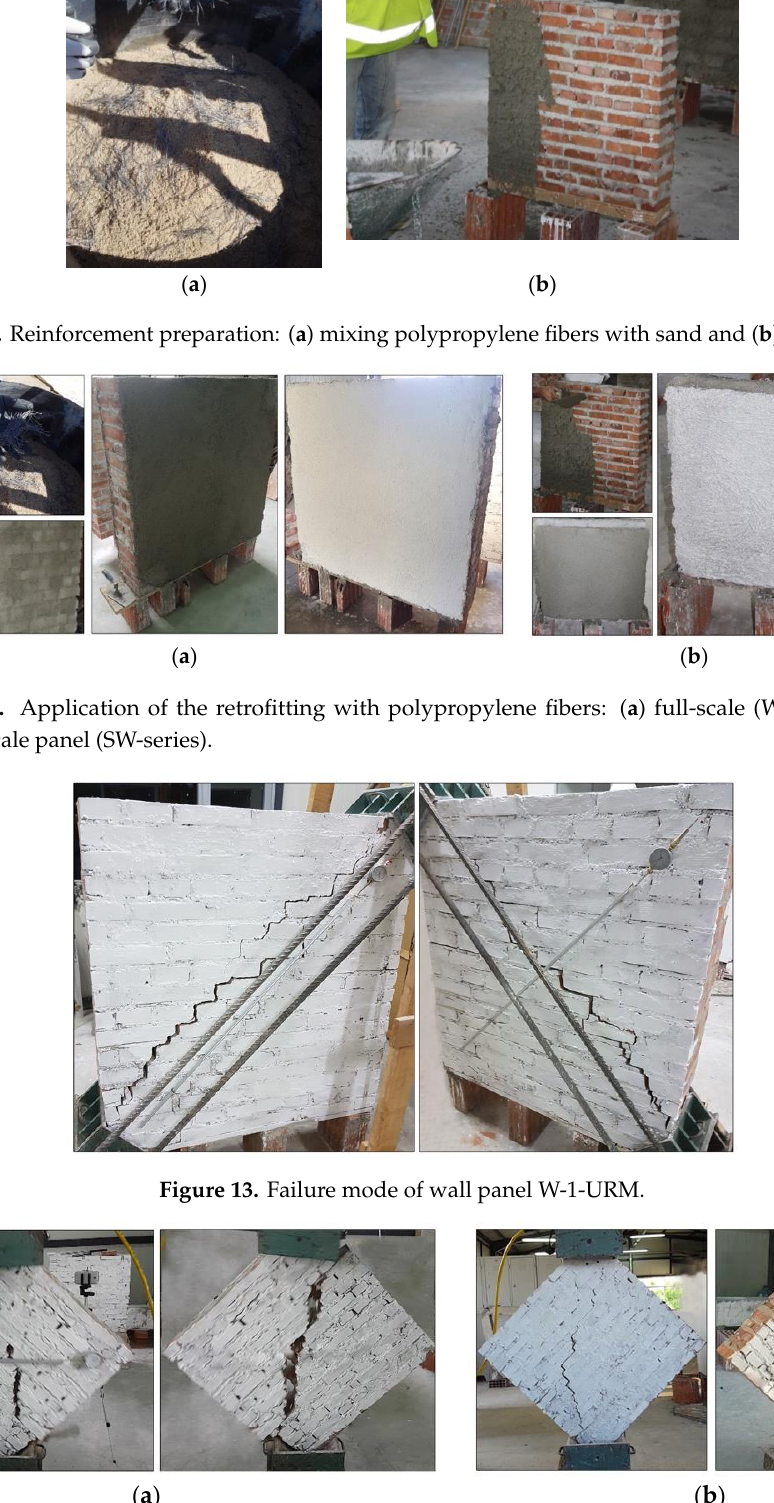
Figure 14. Failure mode of the half-size URM wall panels: ( a ) SW-1-URM and ( b ) SW-2-URM. The shear stress versus shear strain response of all panels was determined by calculating the shear stress and the angular strain using Equations (1) and (3), respectively. For the URM